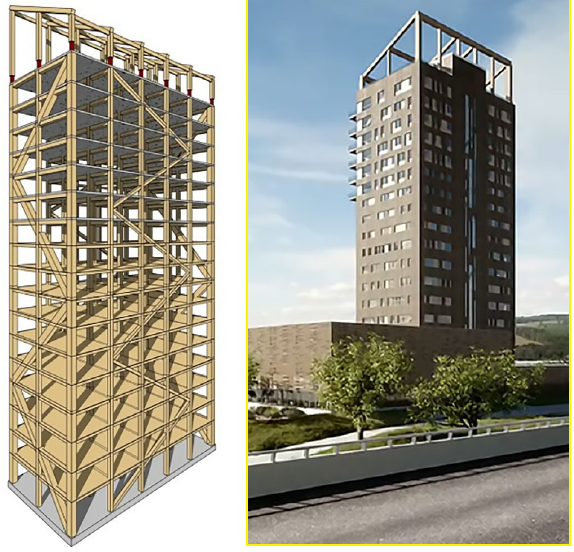
Figure 3. Mjøsa Tower , Brumunddal, Norway (Voll Arkitekter, 2019) Brock Commons Tallwood House ( A ). Brock 2